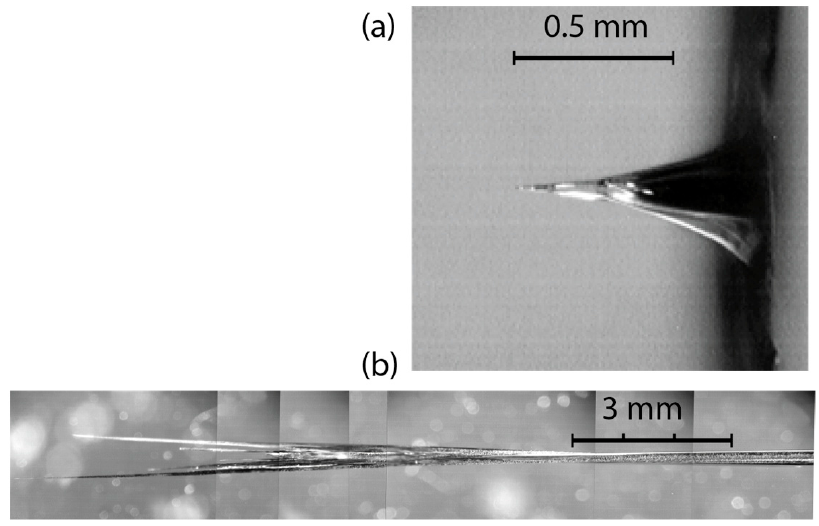
Figure 5. Microscopic images of final channels produced in PMMA by a 10 Hz train of pulses with ( a ) E L = 0.3 mJ and ( b ) 22.3 mJ (a fragment of the channel end is shown). The laser beam falls on the sample from the right.